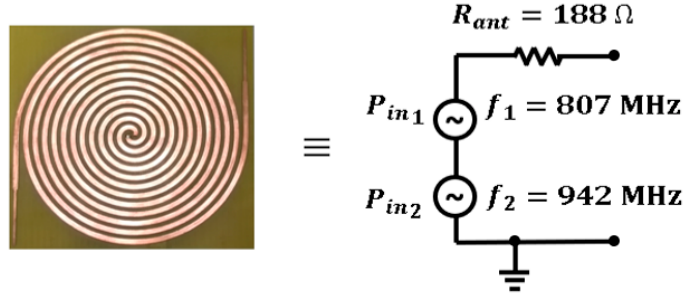
Figure 11. Circuit model of the Archimedean spiral antenna.